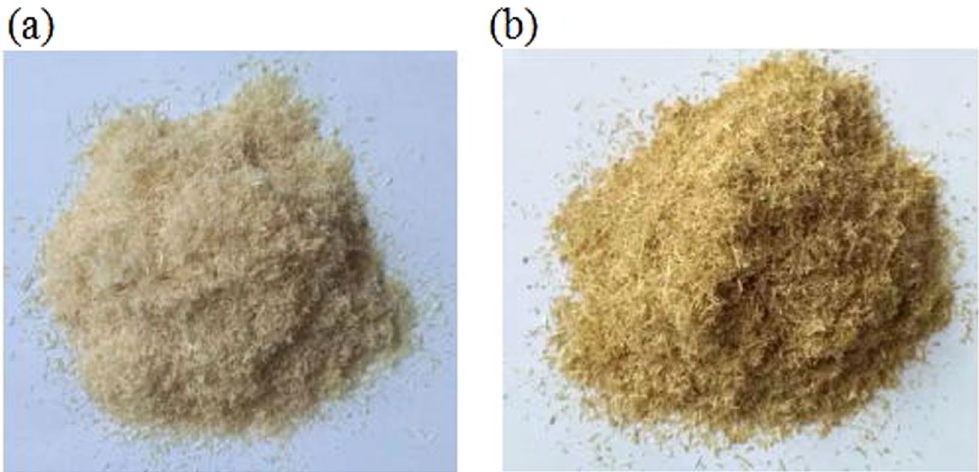
Figure 1. Photographs of different carriers. ( a ) Wood chips; ( b ) Maize straw.